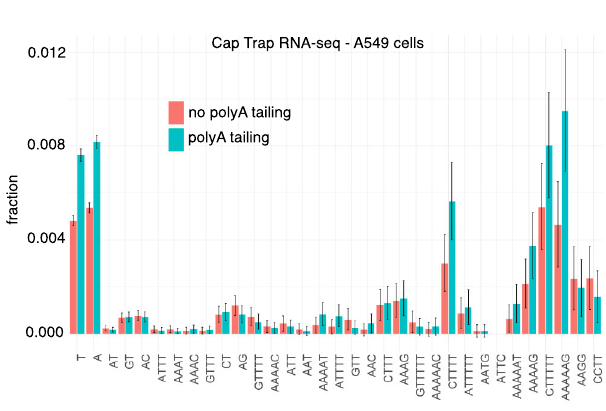
Fig. 3 CTR-seq con fi rms the existence of transcription initiation at STRs. The fractions of STRs associated with at least one CTR-seq long-read start site were computed for all STR classes considered in Fig. 1b. RNAs were collected in A549 cells. Reverse transcription was preceded (blue) or not (red) by polyA tailing. Binomial proportion 95% con fi dence intervals are indicated and centered on the fraction value ( y